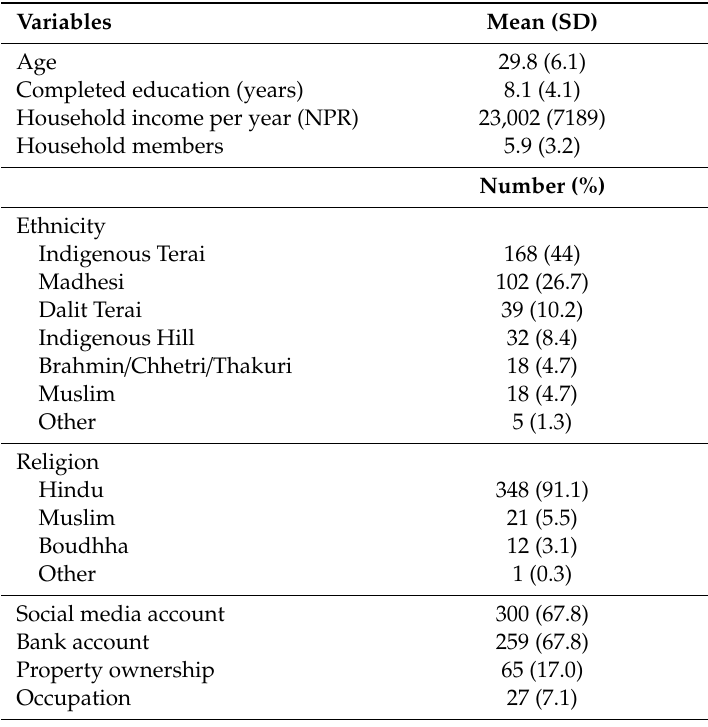
Table 1. Socio-economic characteristics of the